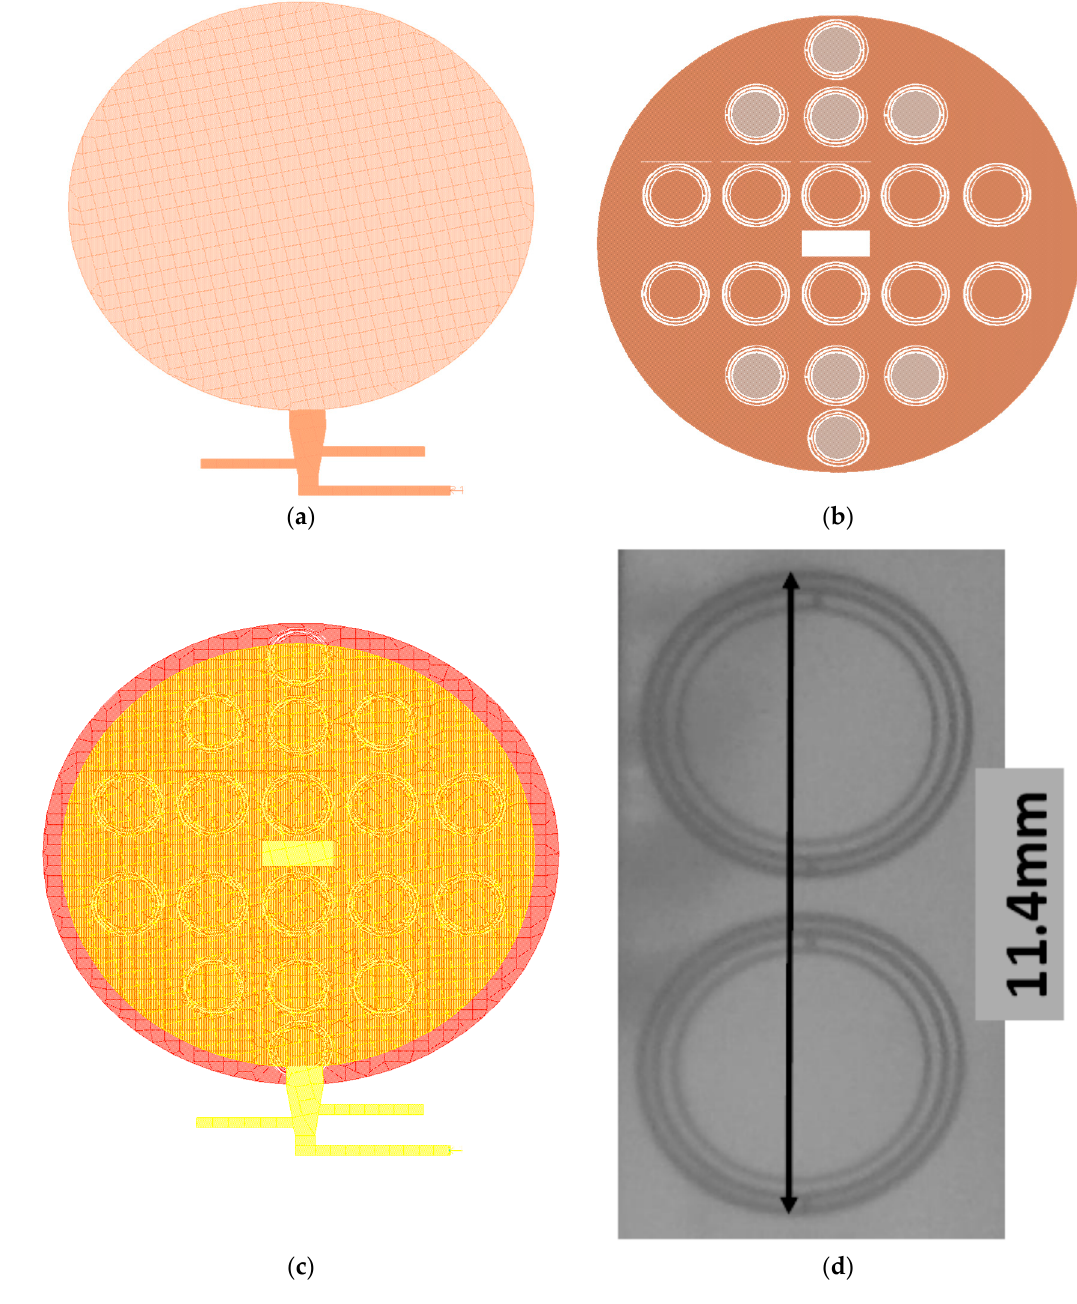
Figure 21. Metamaterial Wearable Double Layer Circular Patch Antennas ( a ) Resonator; ( b ) Metamaterial Radiator; ( c ) Metamaterial Wearable Double Layer Circular Patch; ( d ) CSRRs Photo.